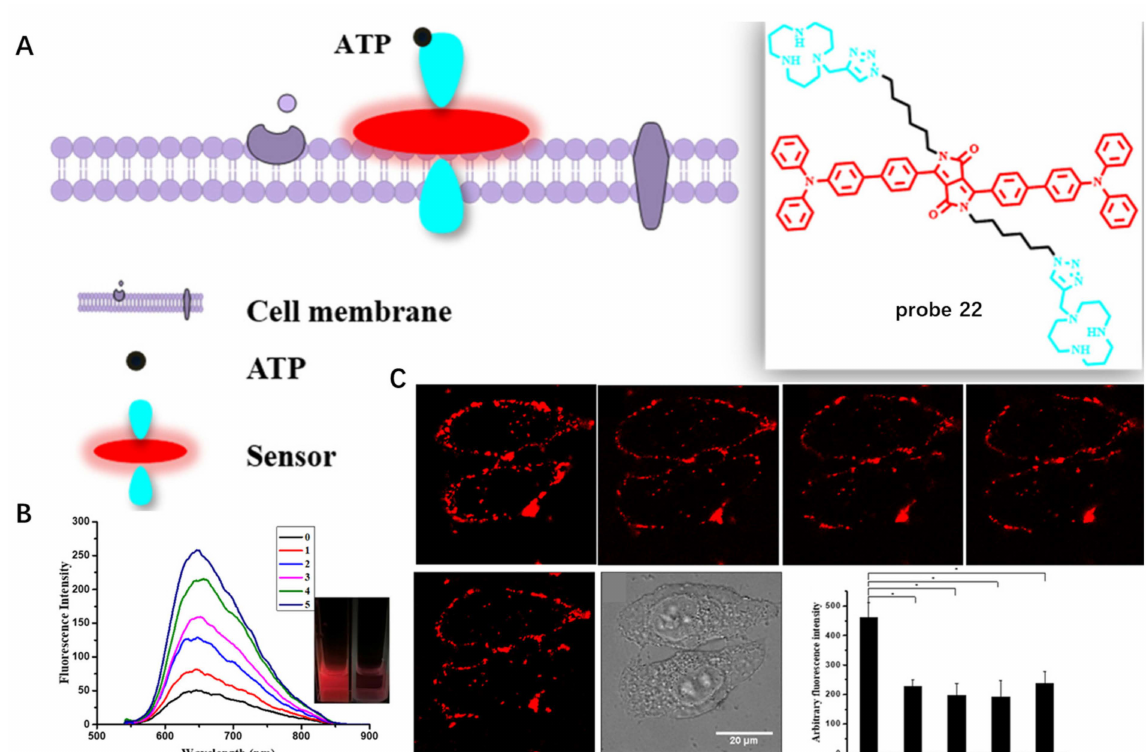
Figure 22. ( A ) Chemical structure of probe 22 and schematic illustration of extracellular ATP detection. ( B ) Fluorescence spec-tra of the probe 22 responding to ATP. ( C ) Fluorescence imaging of HeLa cells with probe 22 for different time. Scale bar: 20 µ m. Copyright 2022 Royal Society of Chemistry